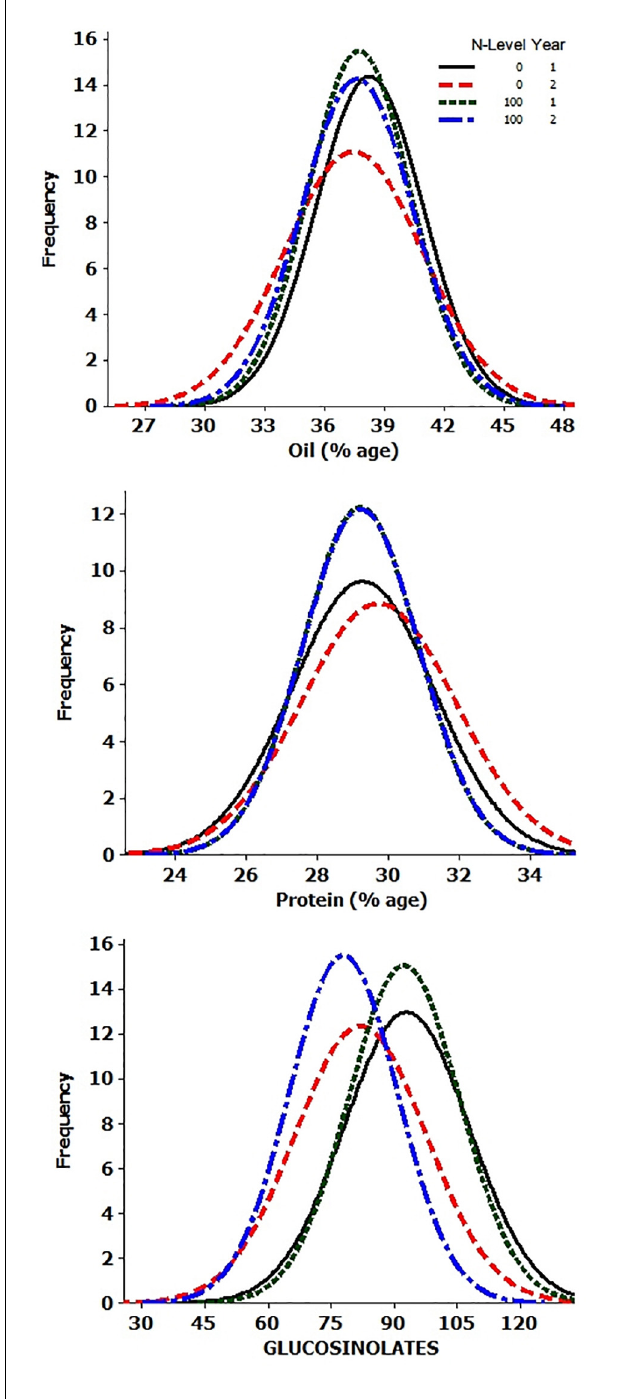
FIGURE 1 | Frequency histograms of 92 genotypes for oil, protein, and glucosinotes.